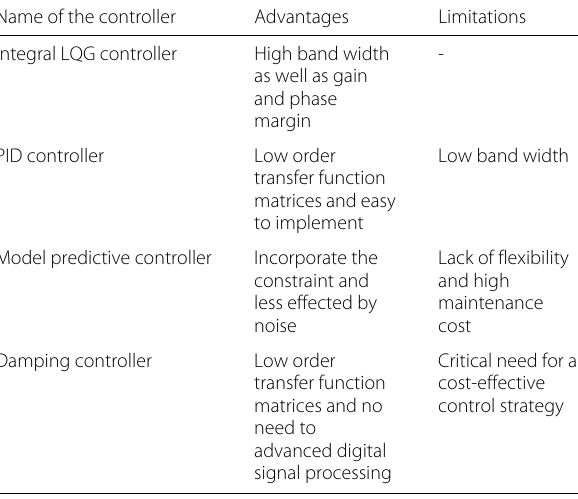
Table 3 Comparisons between the